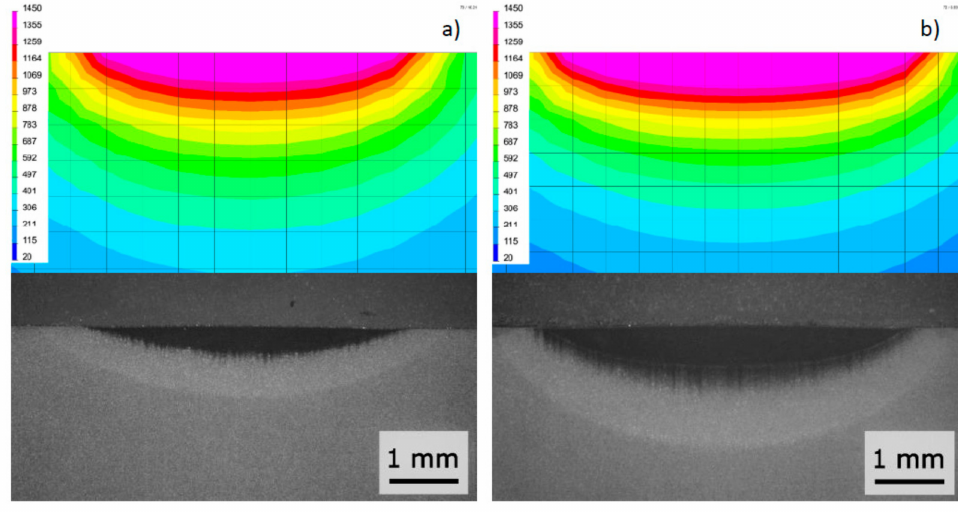
Figure 24. Comparison of the bead shape on the cross-section of sample ( a ) HPDL_R1 and ( b ) HPDL_R2 with the results of numerical analyses.